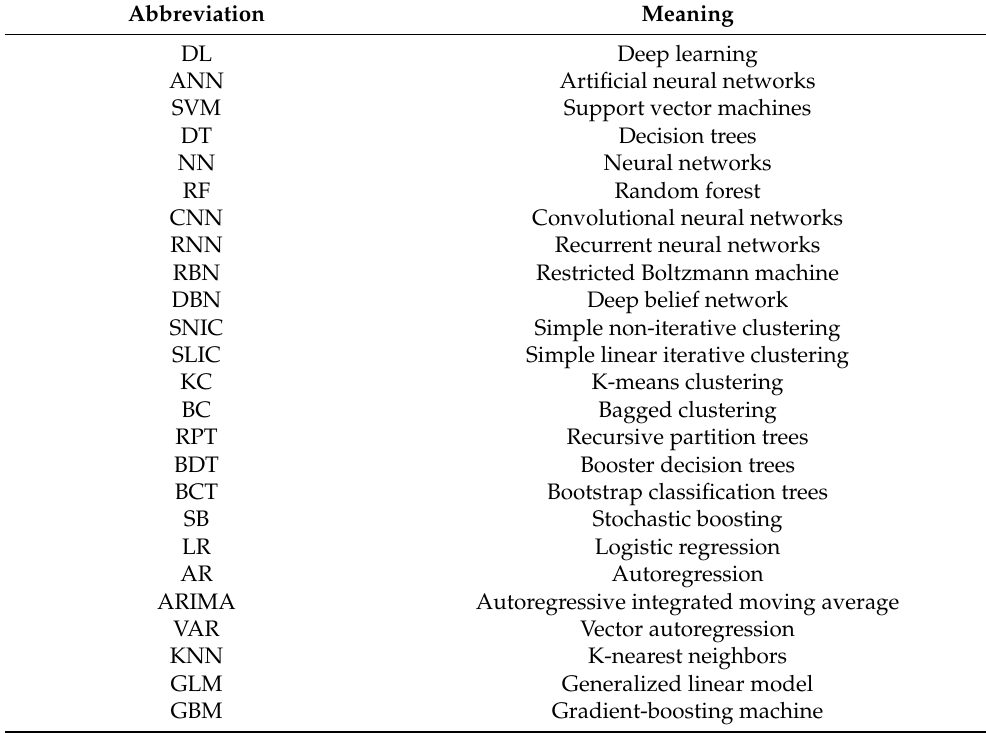
Table 1. Abbreviations for ML techniques and learning algorithms.